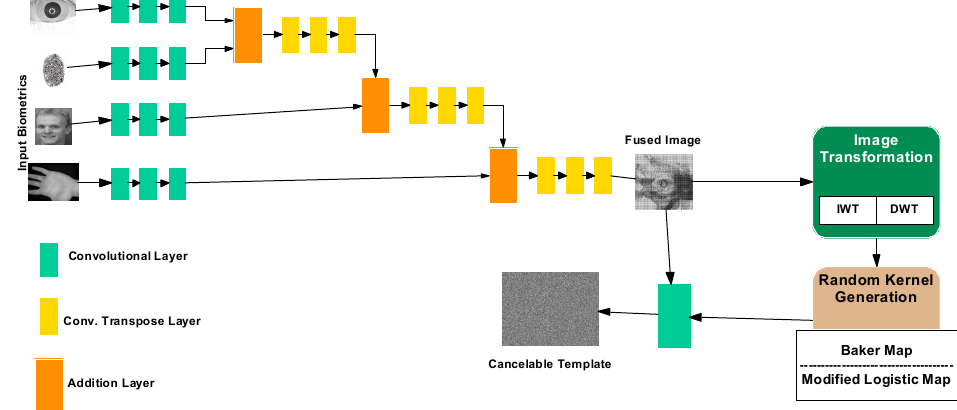
Figure 8. The stages for the suggested system for cancelable fingerprint recognition.